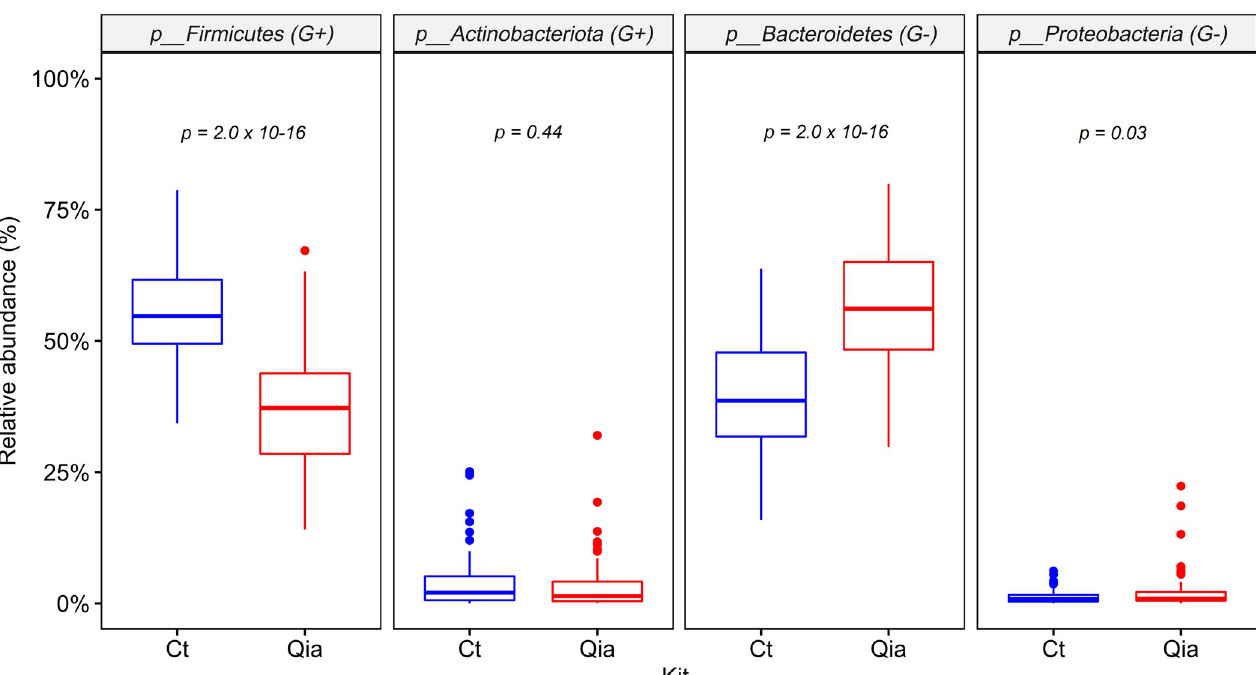
Fig 3. Comparison of relative abundance of four major microbiomes at phylum level using Ct and Qia kits. G+: Gram-positive bacteria. G-: Gram-negative bacteria.